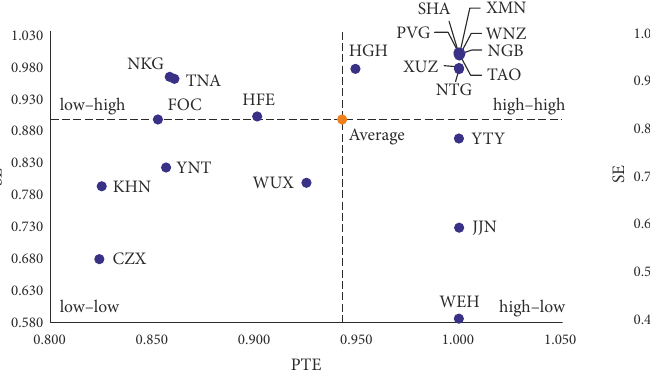
Figure 7. Categorizations of PTE and SE of 20 airports in the third